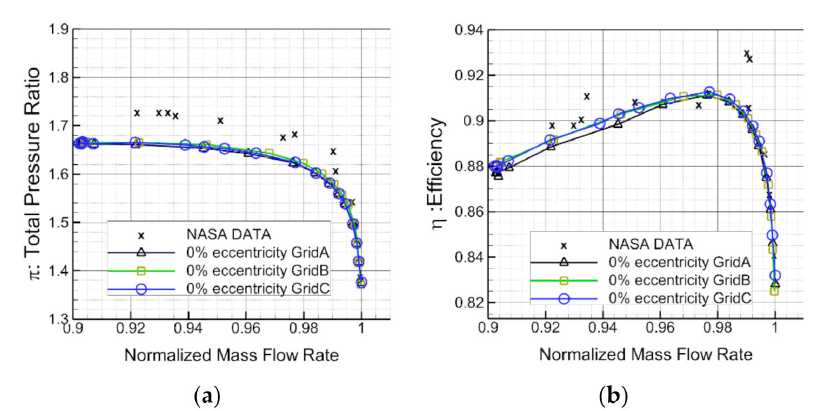
Figure 7. Comparison of experimental and calculated characteristic lines. ( a ) Total pressure ratio characteristic line; ( b ) total e ffi ciency characteristic line.